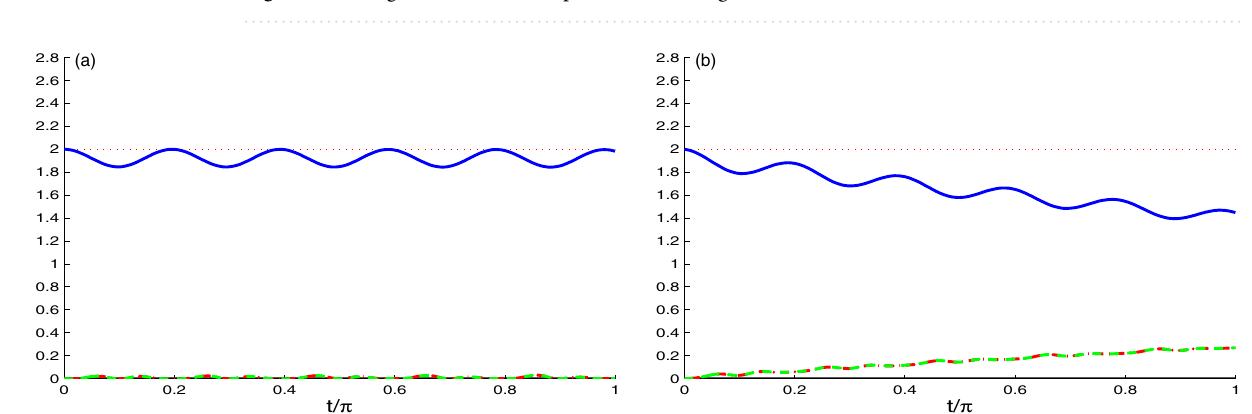
Figure 2. As Fig. 1 but for, the competition case J